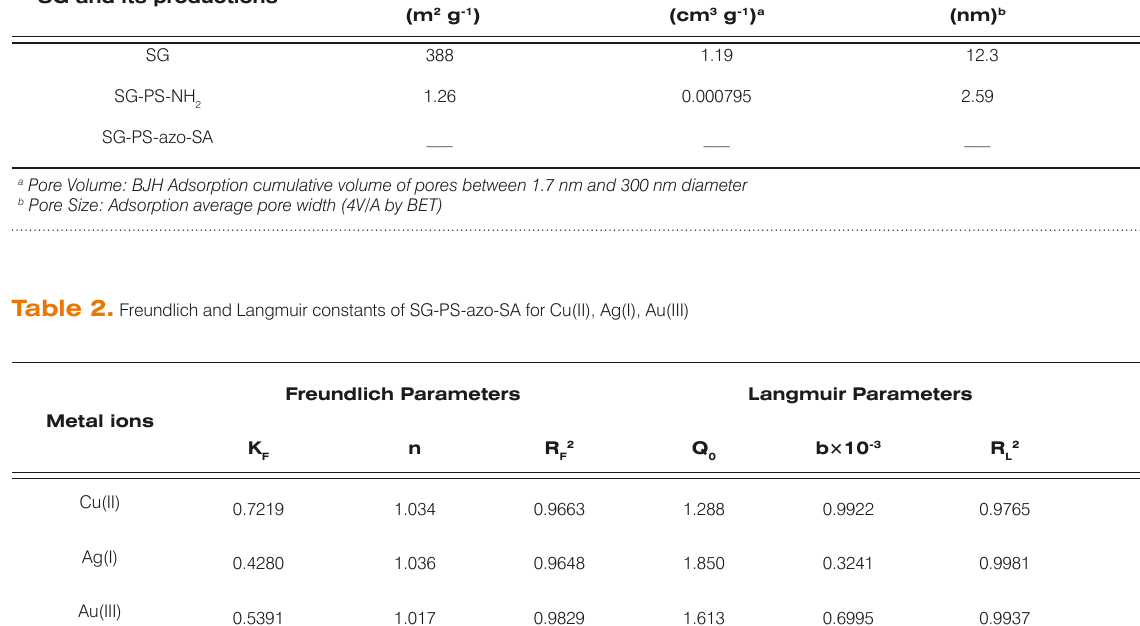
Table 1. Porous structure parameters of SG, SG-PS-NH